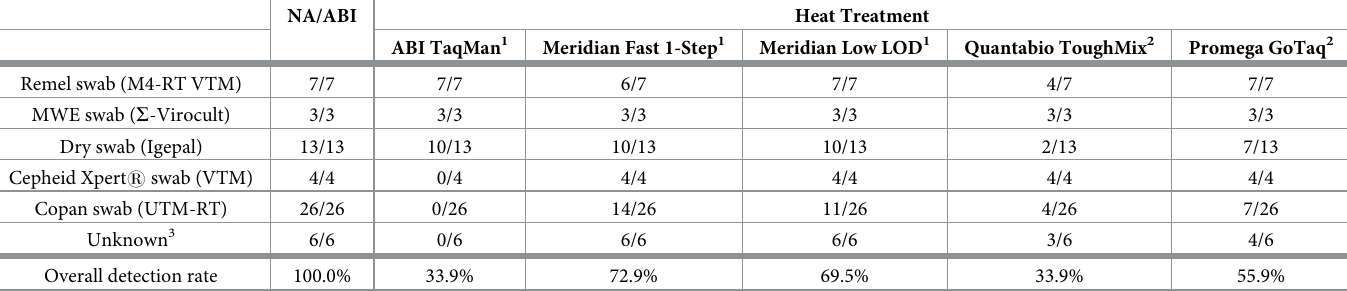
Table 3. Evaluation of the sensitivity of different commercially available RT-PCR kits in different swab sample types re-tested following heat treatment (5min at 95˚C) compared to nucleic acid